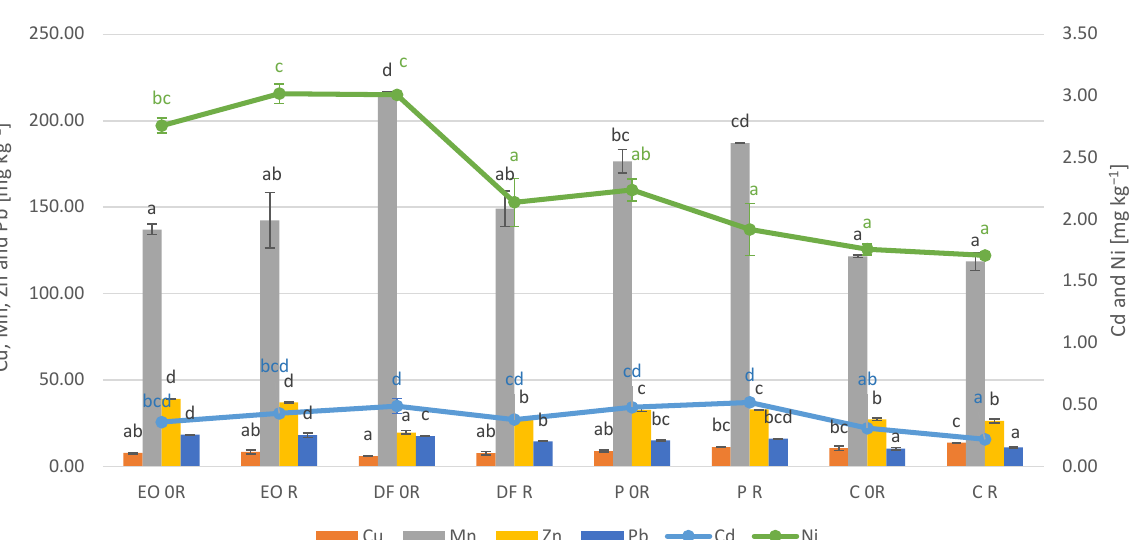
8 of 21 Figure 2. The effect of PDSs and bioremediation on the content of potassium, magnesium, phosphorus and sulfur in the experimental soil (potentially bioavailable elements). The means (± SE) for individual elements that are marked with the same letters did not differ significantly according to Tukey’s test at p < 0.05. The symbols are the same as those in Table 3.